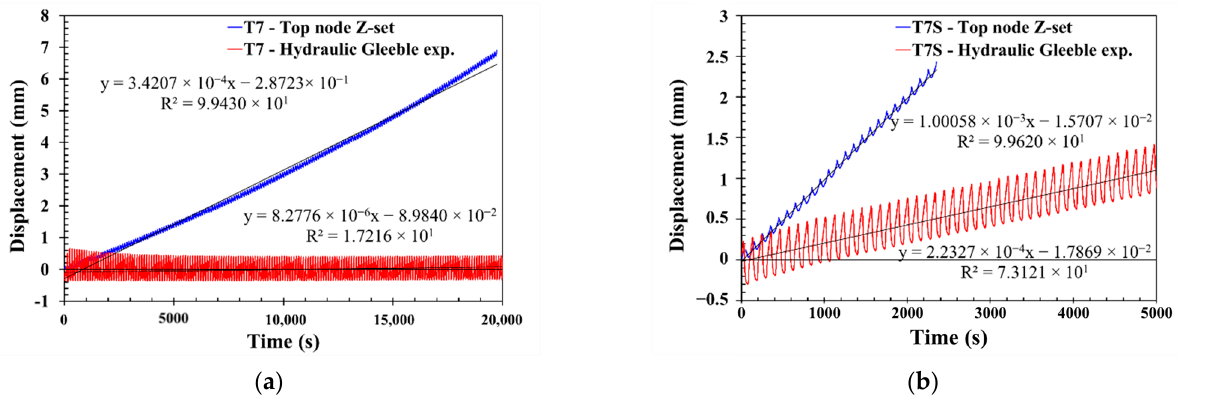
Figure 9. Experimental stroke of hydraulic cylinder for the movable jaw compared to the dis- placement of outside node at the upper end of the specimen (intersection of Top and Ext edges) to condition ( a ) T7 and ( b ) T7S calculated by the LM&C EV EP law.